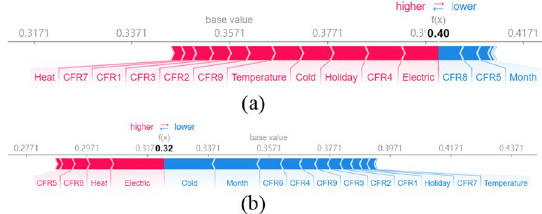
Fig. 10 Local SHAP value distribution of electric load prediction. ( a ) In summer. ( b ) In winter